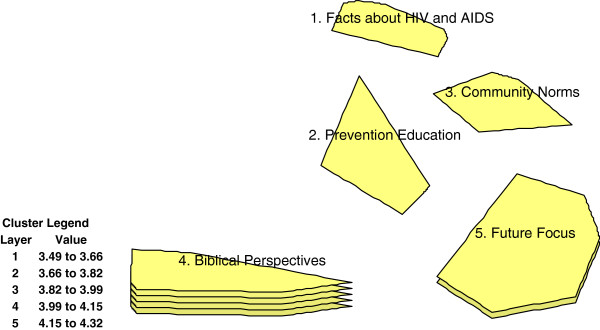
Cluster rating map for messages perceived to be received by Botswana Pentecostal youths orphan to influenced their sexual decisions. Participants rated message statements on the criterion of importance to their HIV prevention decisions. Higher stacked clusters indicate those considered particularly important to the youth HIV prevention. With an observed sten statistic of .27, the five cluster solution explains 73% the variance in the data; - suggesting a high stability or repeatability with a similar sample of church youths.